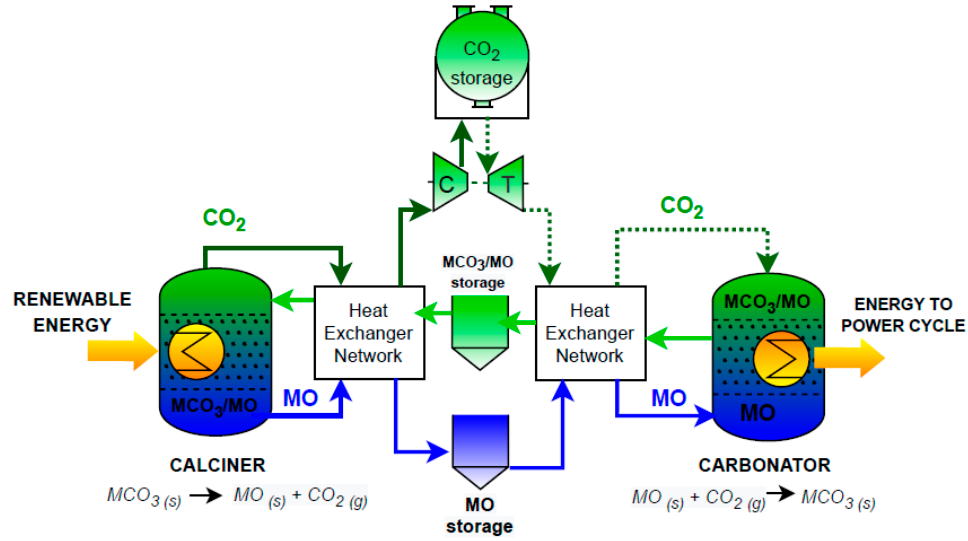
Figure 1. Carbonate-based TCES conceptual scheme. Adapted from [5].